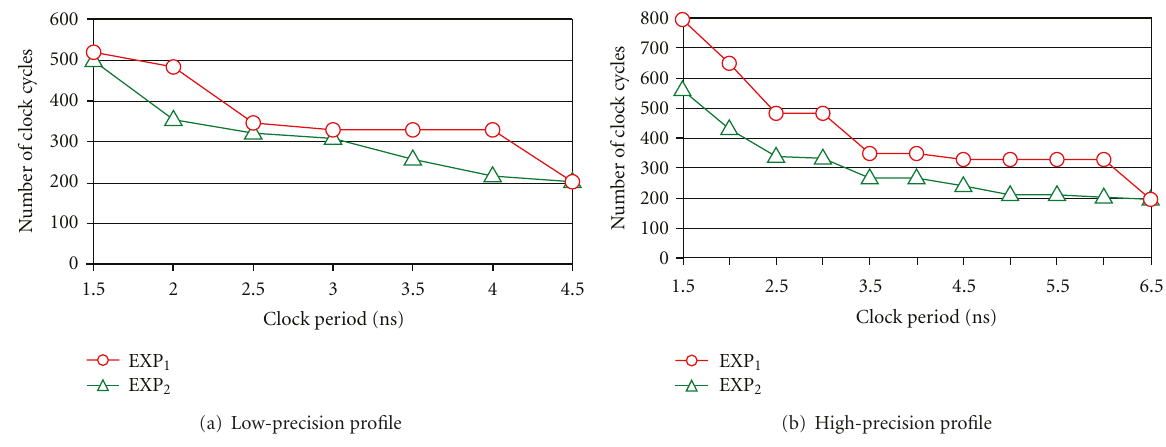
Figure 9: Design latency when the synthesis is constrained by the large set of operators—65 nm ASIC technology.